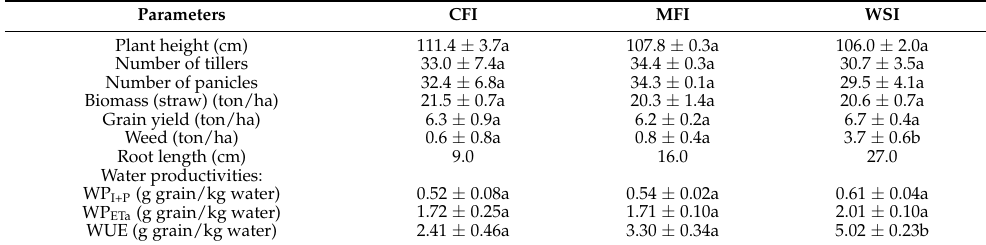
Figure 9. The average plant height among the regimes. Based on statistical analysis, there was no significant difference in crop growth performance, including in plant height, number of tillers, number of panicles, biomass (straw) weight and grain yield (Table 4). Indeed, the CFI regime produced the highest plant height, which correlated to the heaviest straw weight. However, it was only about 5.6% higher than those of the others two regimes. Meanwhile, the MFI regime, although it produced lower plant heights than the CFI regime, it produced the greatest number of tillers and number of panicles. Its quantity was 5–10% higher than those of the CFI and WSI regimes, respectively. The exciting things occurred in the WSI regime that produced the highest grain yield. Although not significant, it was 6% and 7.5% higher than the CFI and MFI regimes, respectively. The increased grain yield seems to be due to the high grain density [38]. Table 4. Yield, water productivity, and water use efficiency among the regimes.